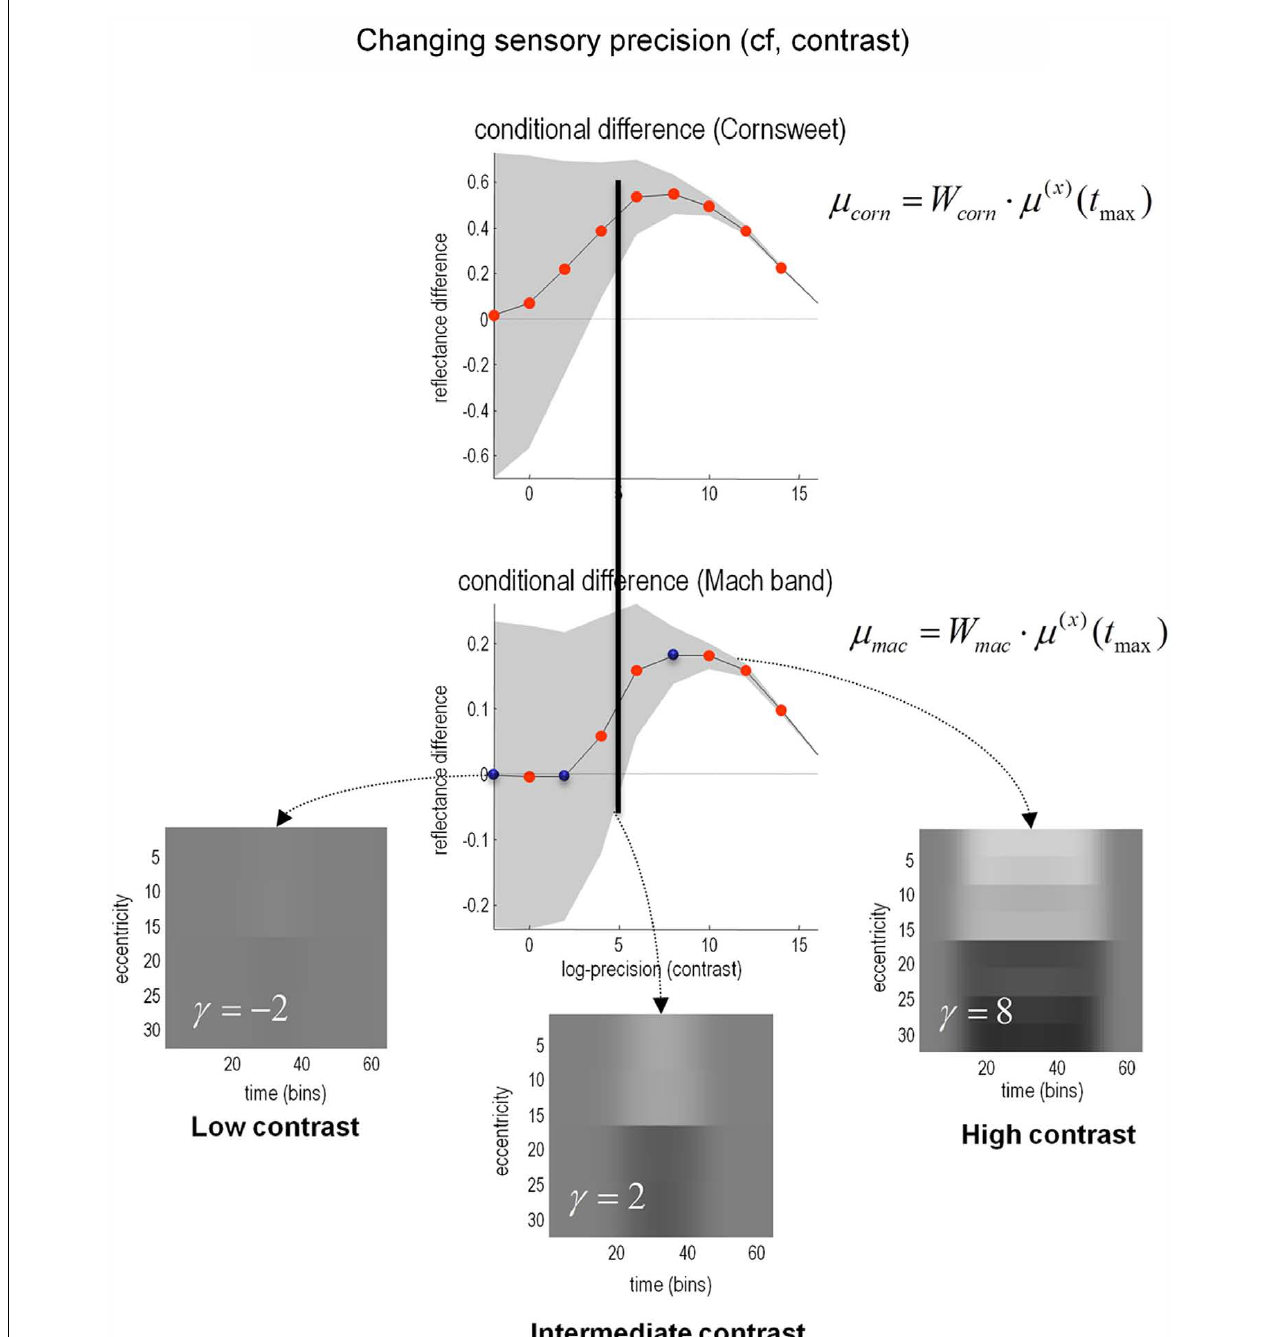
appear at higher levels of contrast than the Cornsweet illusion.The inserts in the lower panels show the inferred reflectance is at different levels of contrast (indicated by the blue dots in the lower graph).The prediction errors associated with the processing of stimuli at these three levels are shown in the next figure. Please see main text for further